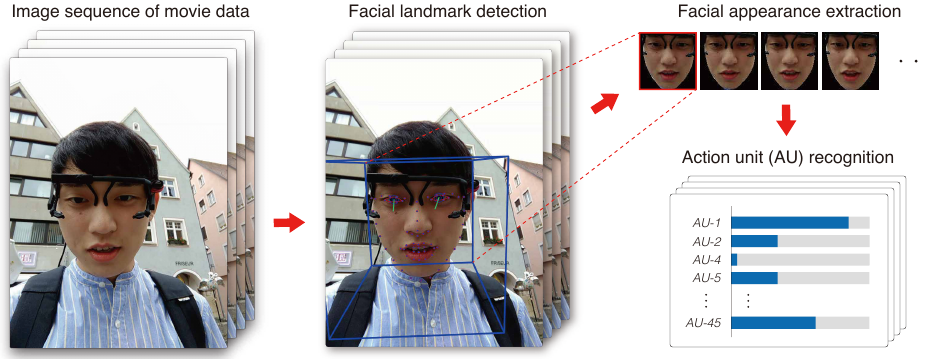
Figure 7. Visual features (action units) extraction using Openface